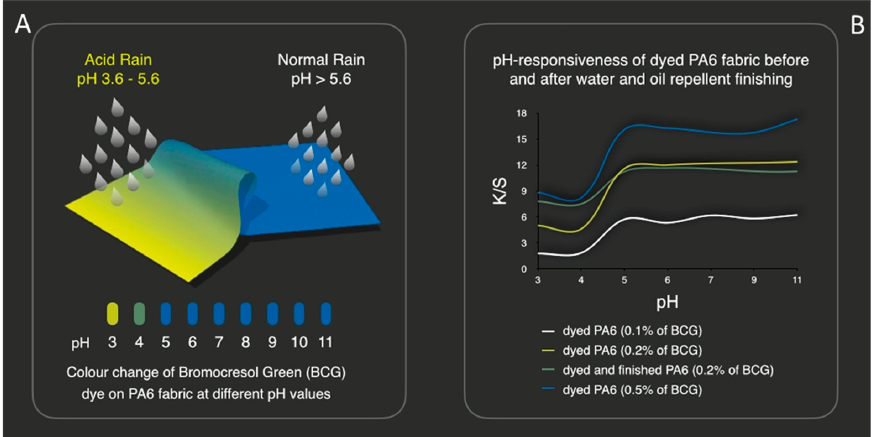
Figure 8. Schematic representation of the color change under different pHs. For acid rain the pH range was from 3.6 to 5.6 while for the normal rain pH was >5.6. The images were adapted from [52] under the Creative Commons Attribution